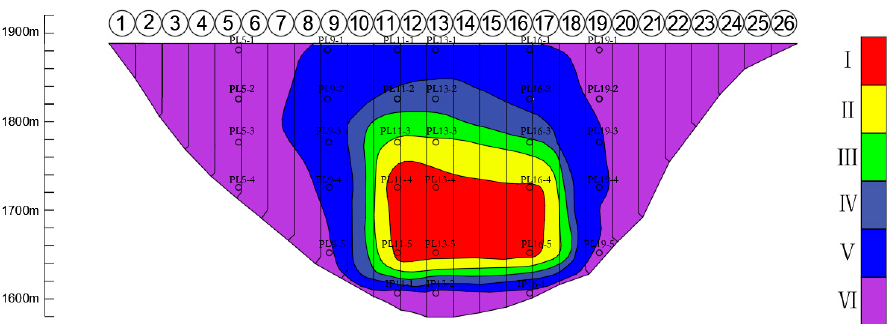
Figure 8. Deformation partition diagram of the ultra-high arch dam during the second phase.